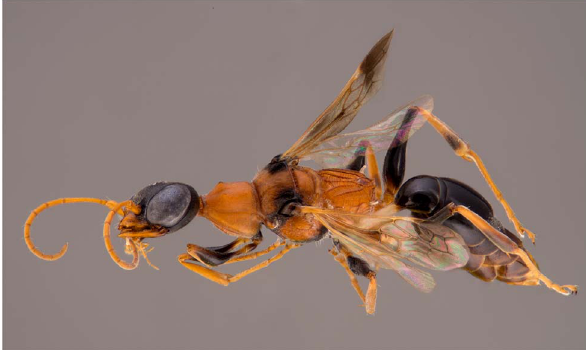
Figure 1. Ampulexdementor n. sp., female, holotype, in oblique lateral view. Pin digitally removed from image. Photo: